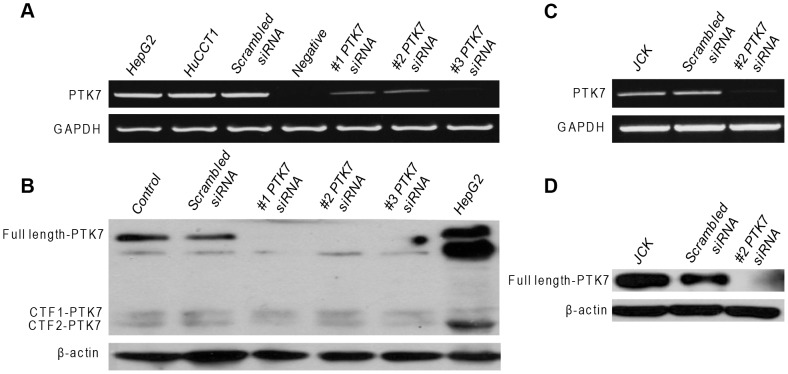
PTK7-specific siRNA silencing in HuCCT1 and JCK cells.(A) PTK7 mRNA and (B) protein levels after transfection of PTK7 siRNAs in HuCCT1 cells. (C) PTK7 mRNA and (D) protein levels after transfection of PTK7 siRNAs in JCK cells.